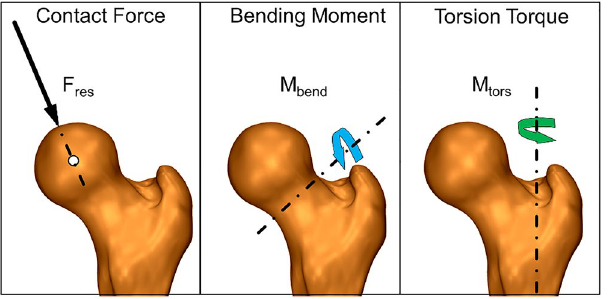
Figure 1. Localisation and direction of the parameters resultant contact force (F res ), bending moment (M bend ) and torsional moment (M tors